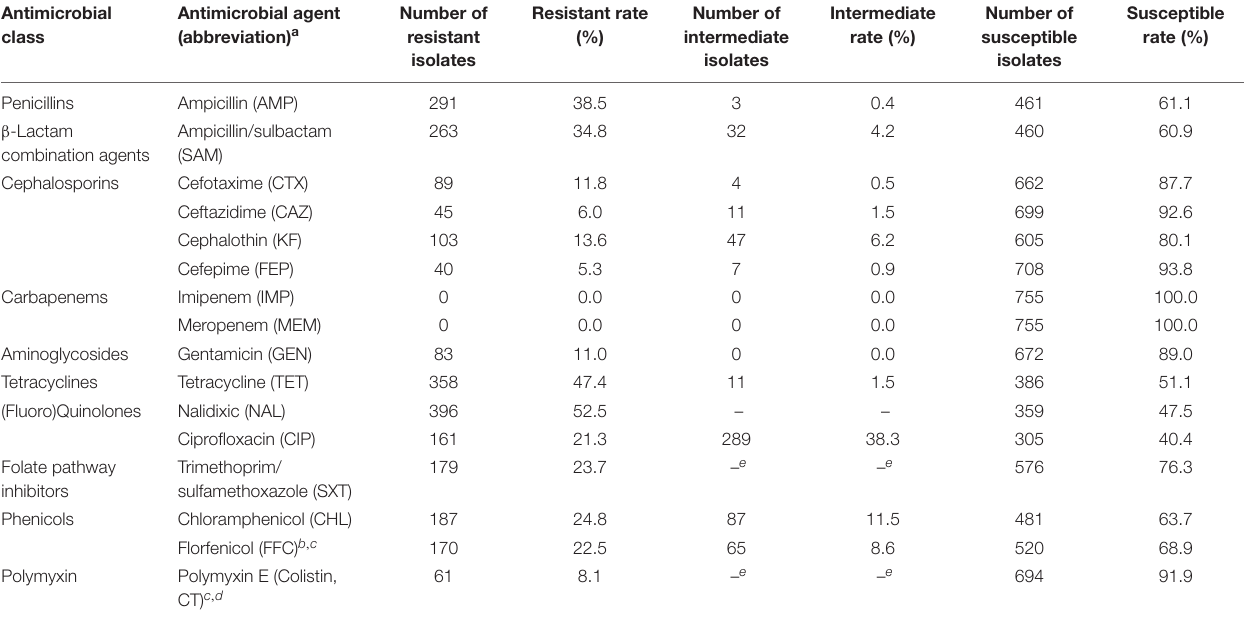
TABLE 1 | Antimicrobial susceptibility of 755 foodborne Salmonella isolates against to a panel of antimicrobial agents. Antimicrobial Antimicrobial agent Number of class (abbreviation) a